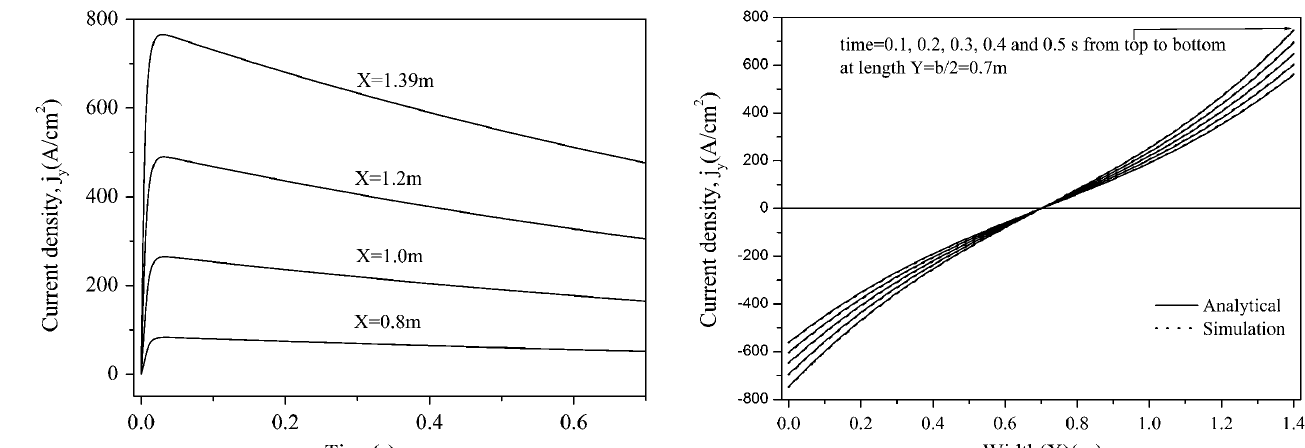
FIG. 11. Variation of the eddy current density, j the aluminum plate of dimension ð 1 : 4 ; 1 : 4 ; 0 : 002 Þ m 3 at different times obtained from two different methods when exposed to an exponentially time decaying